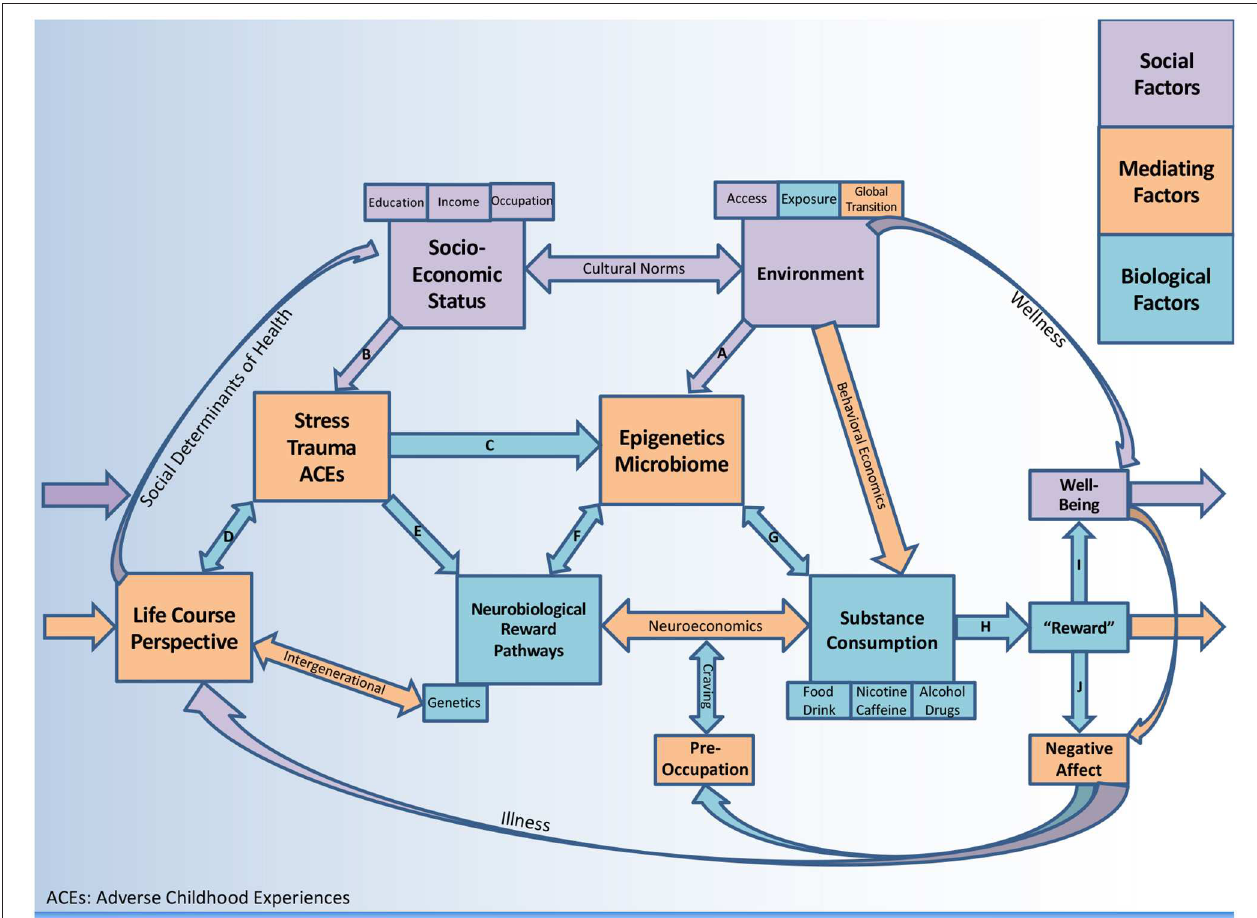
FIGURE 1 | A biopsychosocial perspective on substance